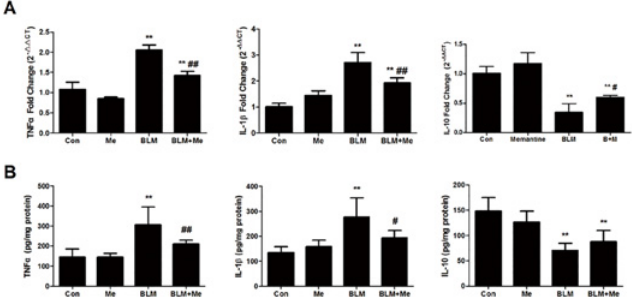
Fig 4. Memantine changed BLM induced gene expression of cytokines in lungs. The lung tissues were collected on Day 7. The levels of TNF α , IL-1 β and IL-10 in lung homogenate were quantified by RT- qPCR (A) and ELISA (B). n = 4 – 6. Bars: mean ± SD. ** P < 0.01 vs Control group; # P < 0.05, ## P < 0.01 vs BLM